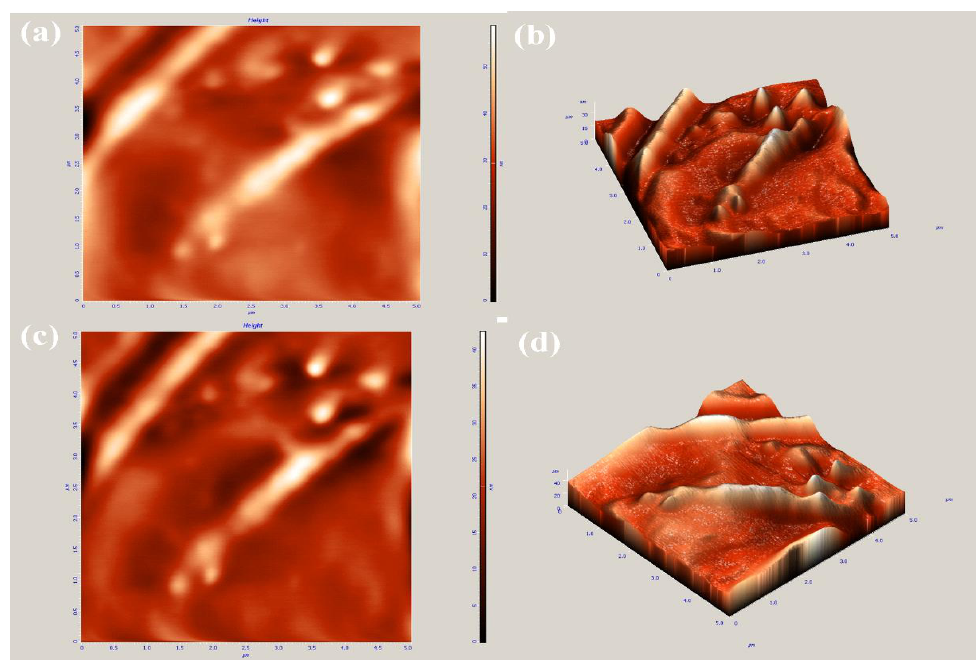
Fig. 3. AFM images of: (a,b) A2 and (c,d) A4